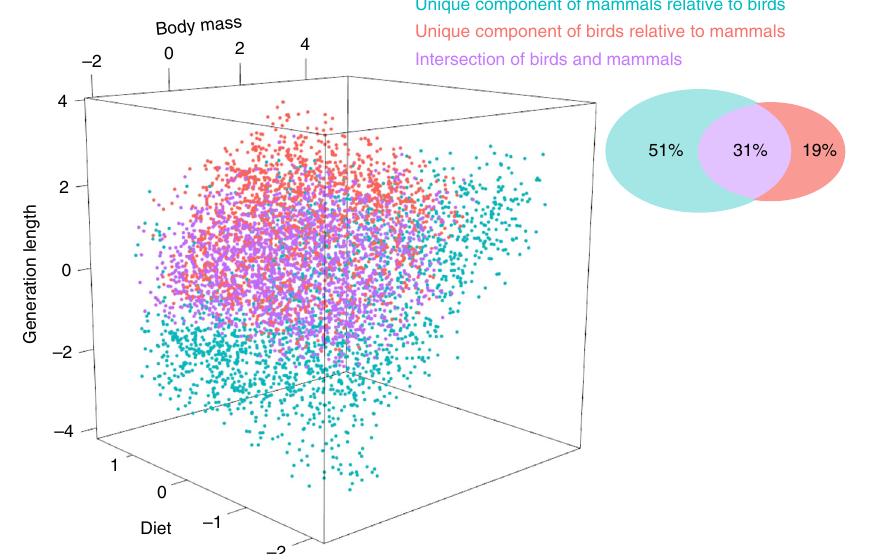
Fig. 2 Overlap between mammal and bird ecological strategy spaces. The separation (unique components) and overlap (intersection) of 15,484 living land mammal and bird species across ecological strategy spaces (hypervolumes). The two ecological strategy spaces (one for mammals, one for birds) are constructed on the basis of the fi ve z-transformed traits, although only the three traits with the highest loadings across the ecological strategy surface are used for visualization: log 10 (body mass), log 10 (generation length) and diet (Fig. 1a; Supplementary Table 1). The Venn diagram shows the percentage of the total combined volume occupied by each component (the percentages sum to 100 before rounding). Source data are provided as a Source Data fi le